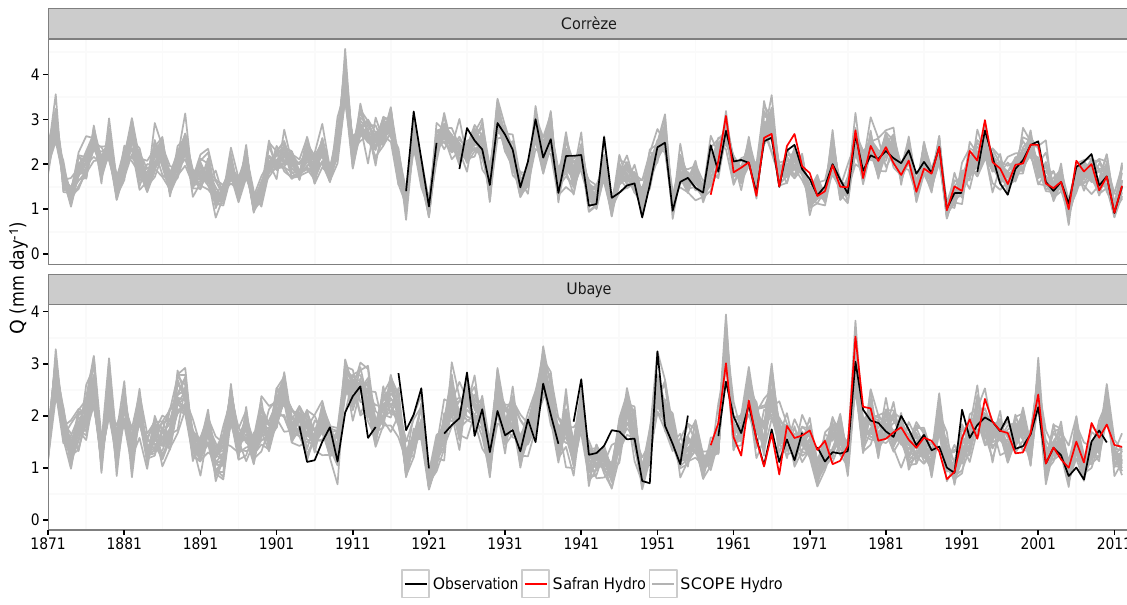
Figure 10. Corrèze and Ubaye annual discharge time series during the 1871–2012 period, from observations, Safran Hydro, and SCOPE Hy- dro. Note the different scales for the y